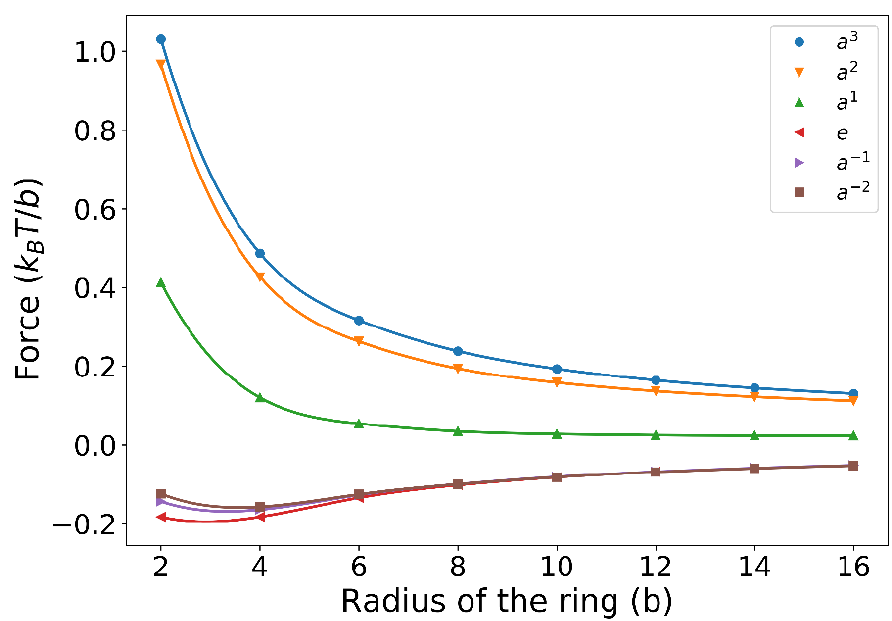
Figure 7. The influence of the overall radius of the ring on the entropic force of an ideal chain entangled with a static ring-shaped object with six different entangling modes. In this plot, the distance, L , between the two chain ends is 3 b .